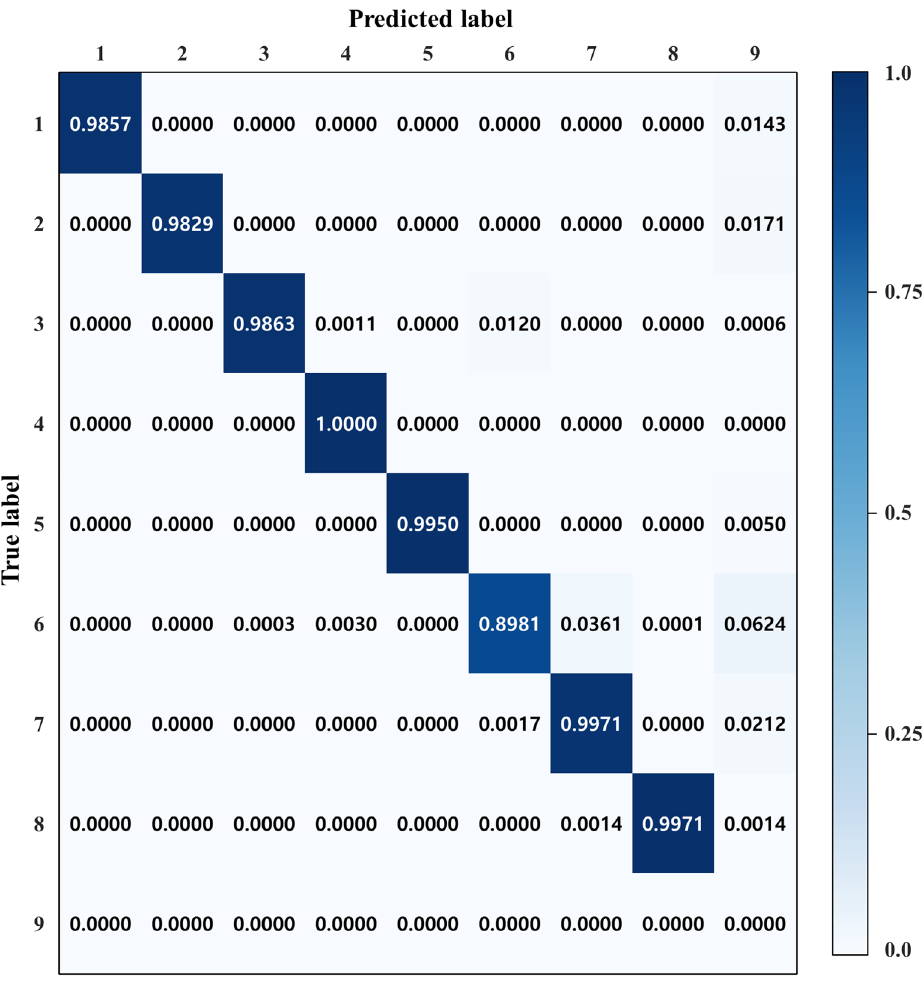
Figure 6. Confusion matrix of machining features in the test dataset classification.